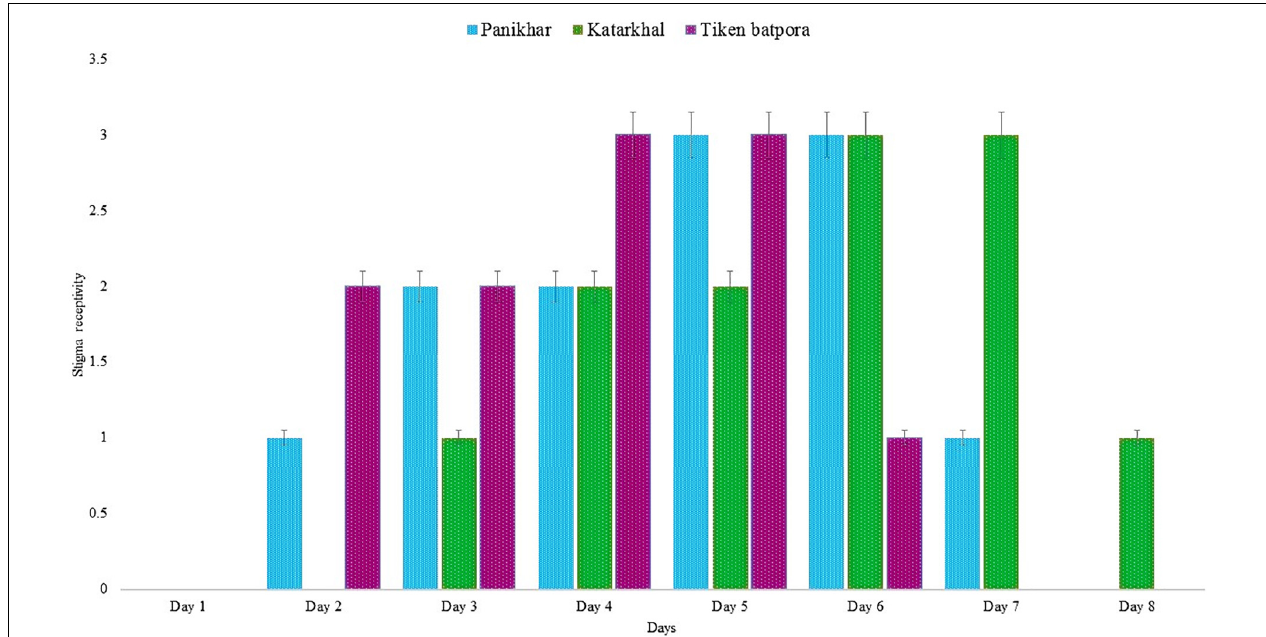
FIGURE 6 | Stigma receptivity in Rheum webbianum where 0 represents no receptivity and 3.5 peak receptivity (bars represent SD for n = 20 replicates). Scale of 0–3.5 is based on the number of bubbles and pollen germinated on